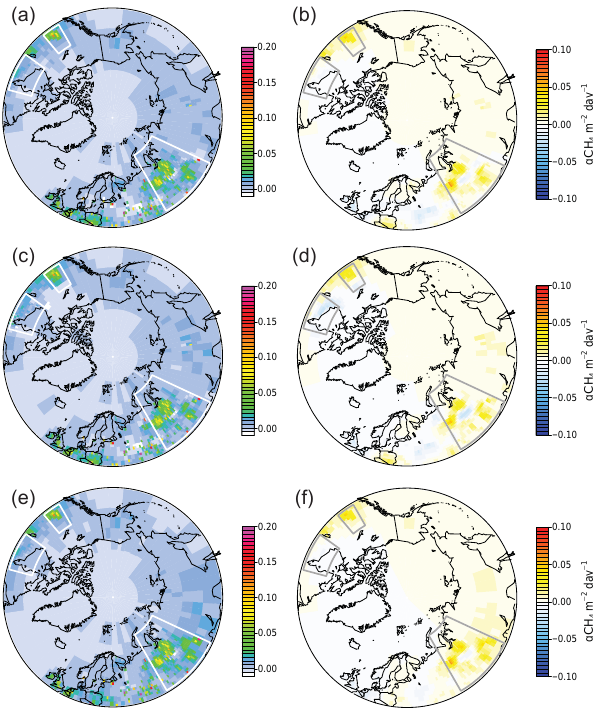
Figure 8. Annual mean posterior fluxes of CH 4 shown for 2009 for scenario S1 (a) , the difference between the posterior and prior fluxes for S1 (b) ; the posterior fluxes for scenario S2 (c) and the difference for S2 (d) ; and the posterior fluxes for scenario S3 (e) and the difference for S3 (f) . The bordered areas are Alberta in western Canada, the Hudson Bay lowlands (HBL) in eastern Canada, and the western Siberian lowlands (WSL) (units are gCH 4 m − 2 day − 1 ) .